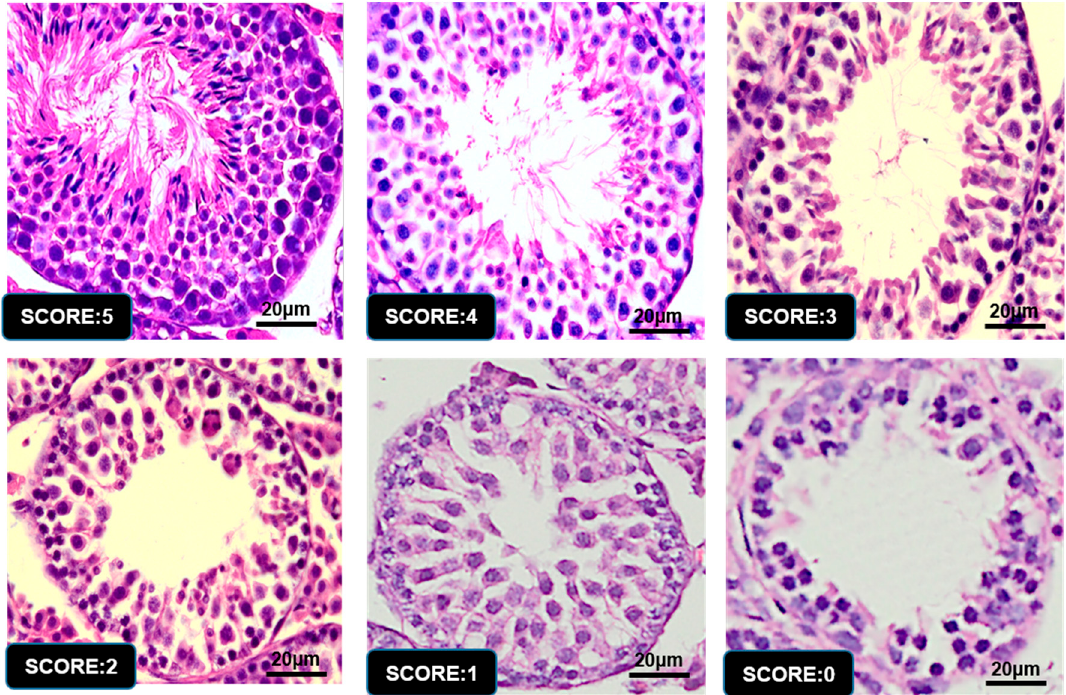
Figure 6. Images of seminiferous epithelia evaluation by testis scoring methodology at the age of day 35. According to the scoring, individual image obtains their respective score for having its differential characteristics of histological structure explained previously in Figure 5 & Figure 6. Images were analyzed using HE staining and were achieved by light microscope under 40 × magnification.